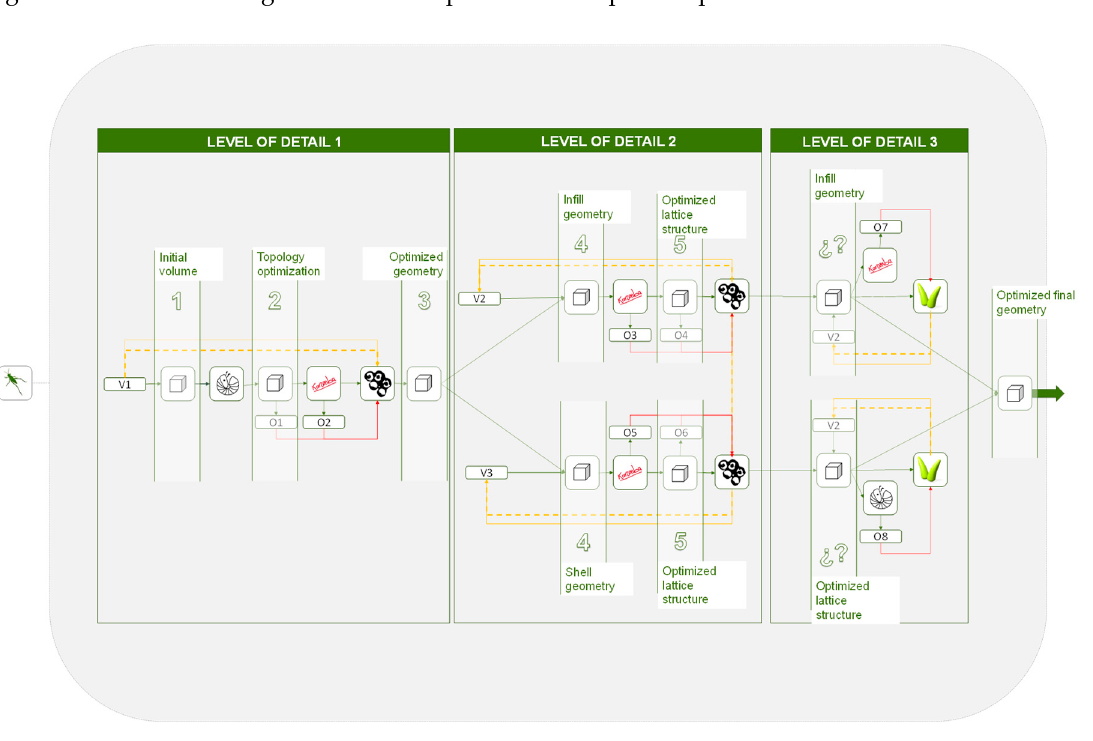
Figure 19. Hierarchical methodology applied to different levels of detail.